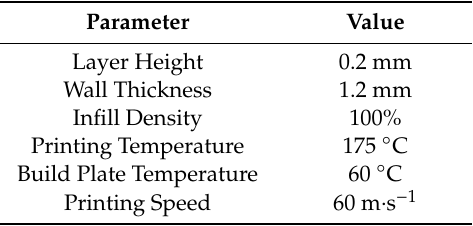
Table 1. 3D print